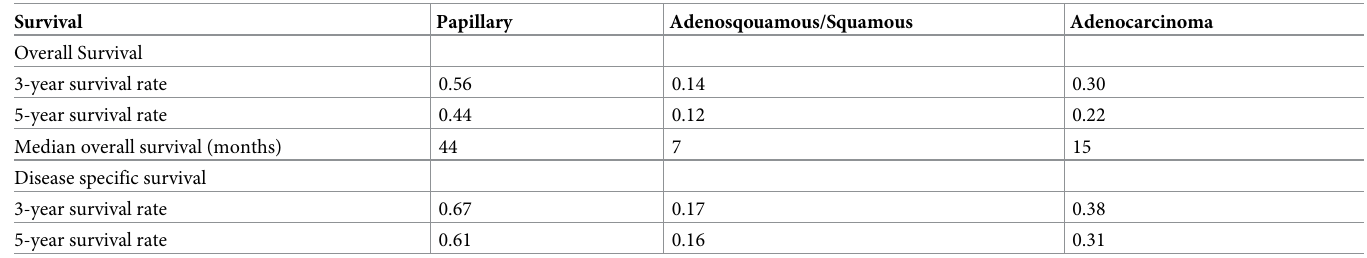
Table 4. Overall survival and disease-specific survival